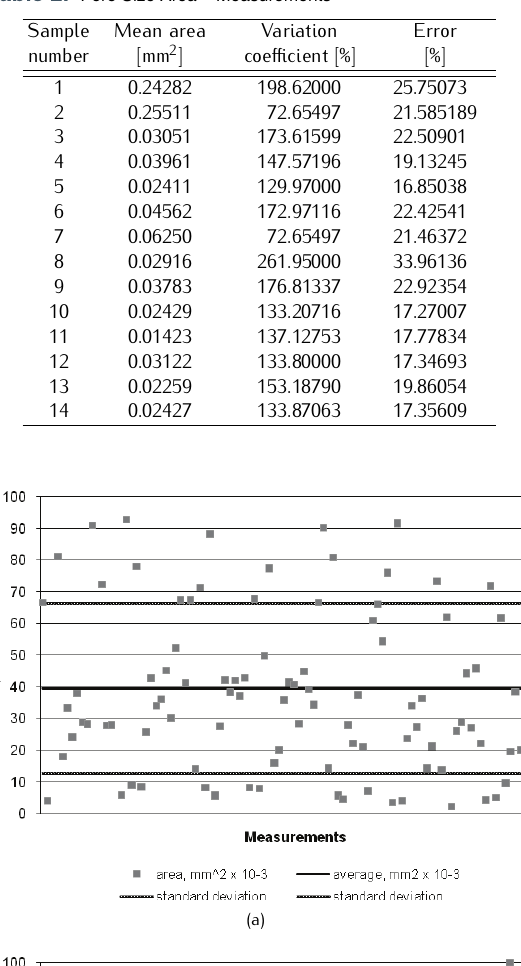
Table 2. Pore Size Area – Measurements